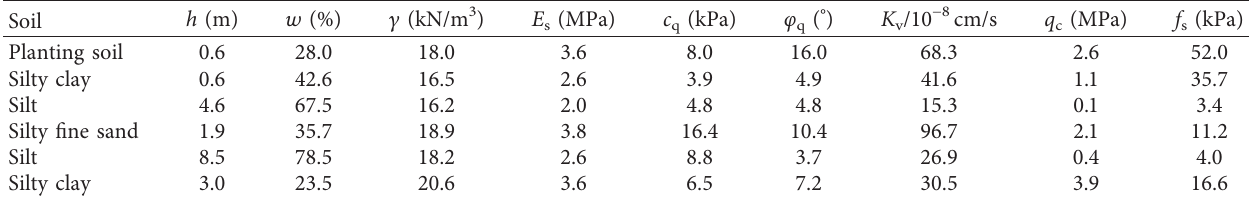
Table 2: Physical and mechanical parameters of each soil layer in section K64